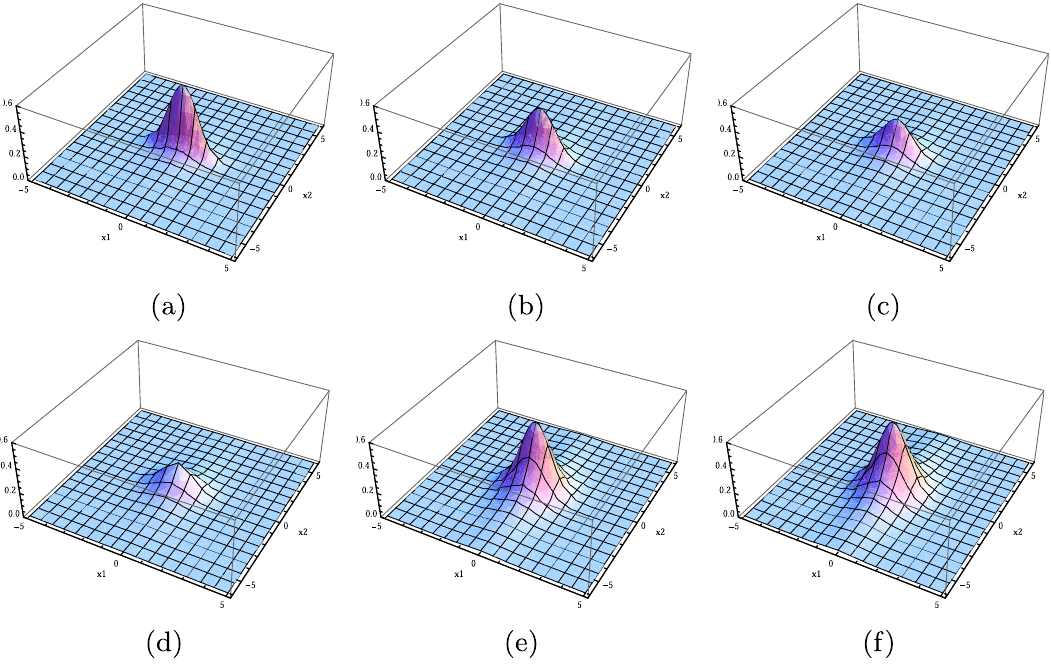
Figure 6: The shape of transition function ( ) p x x , 1 2 when we fi x = t 0.3 , = a 1 and b changes from 1 to 3.5 in the interval of 0.5. (